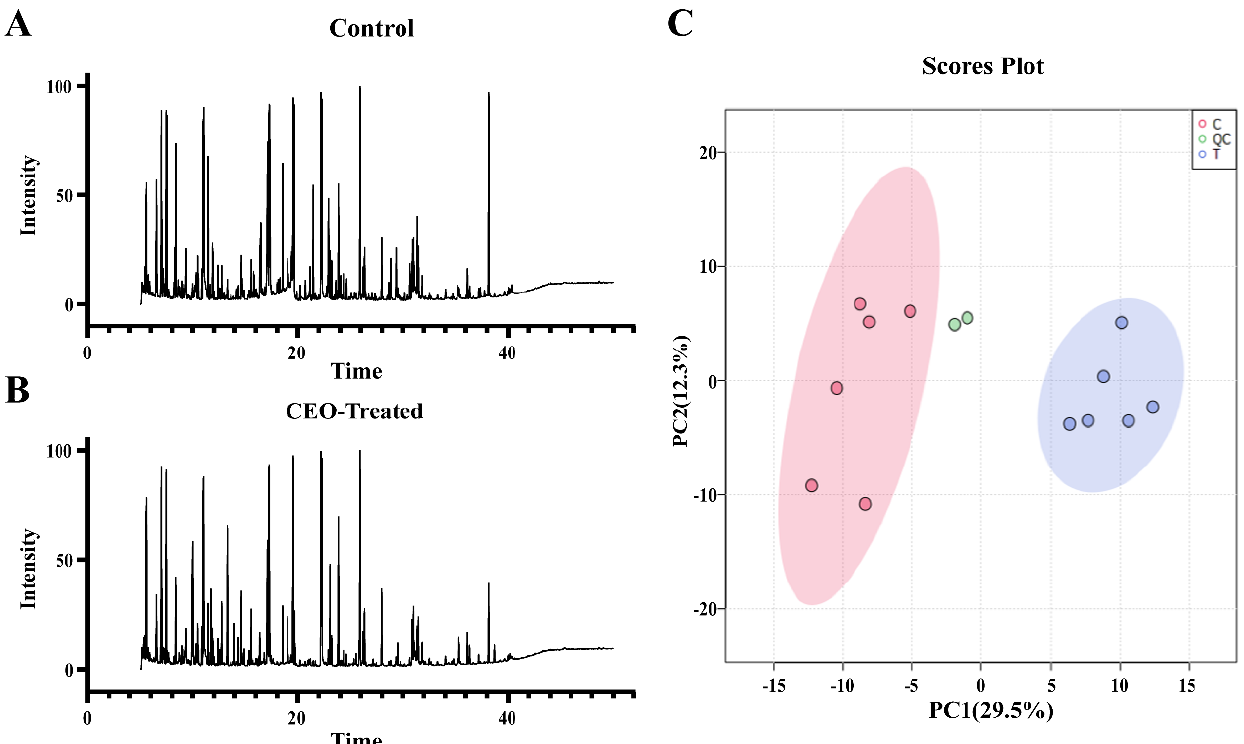
Figure 3. Metabolomic profiling of MRSA. ( A ): Representative total ion current chromatograms of a control sample. ( B ): Representative total ion current chromatograms of a CEO-treated sample. ( C ): PCA analysis of all samples.